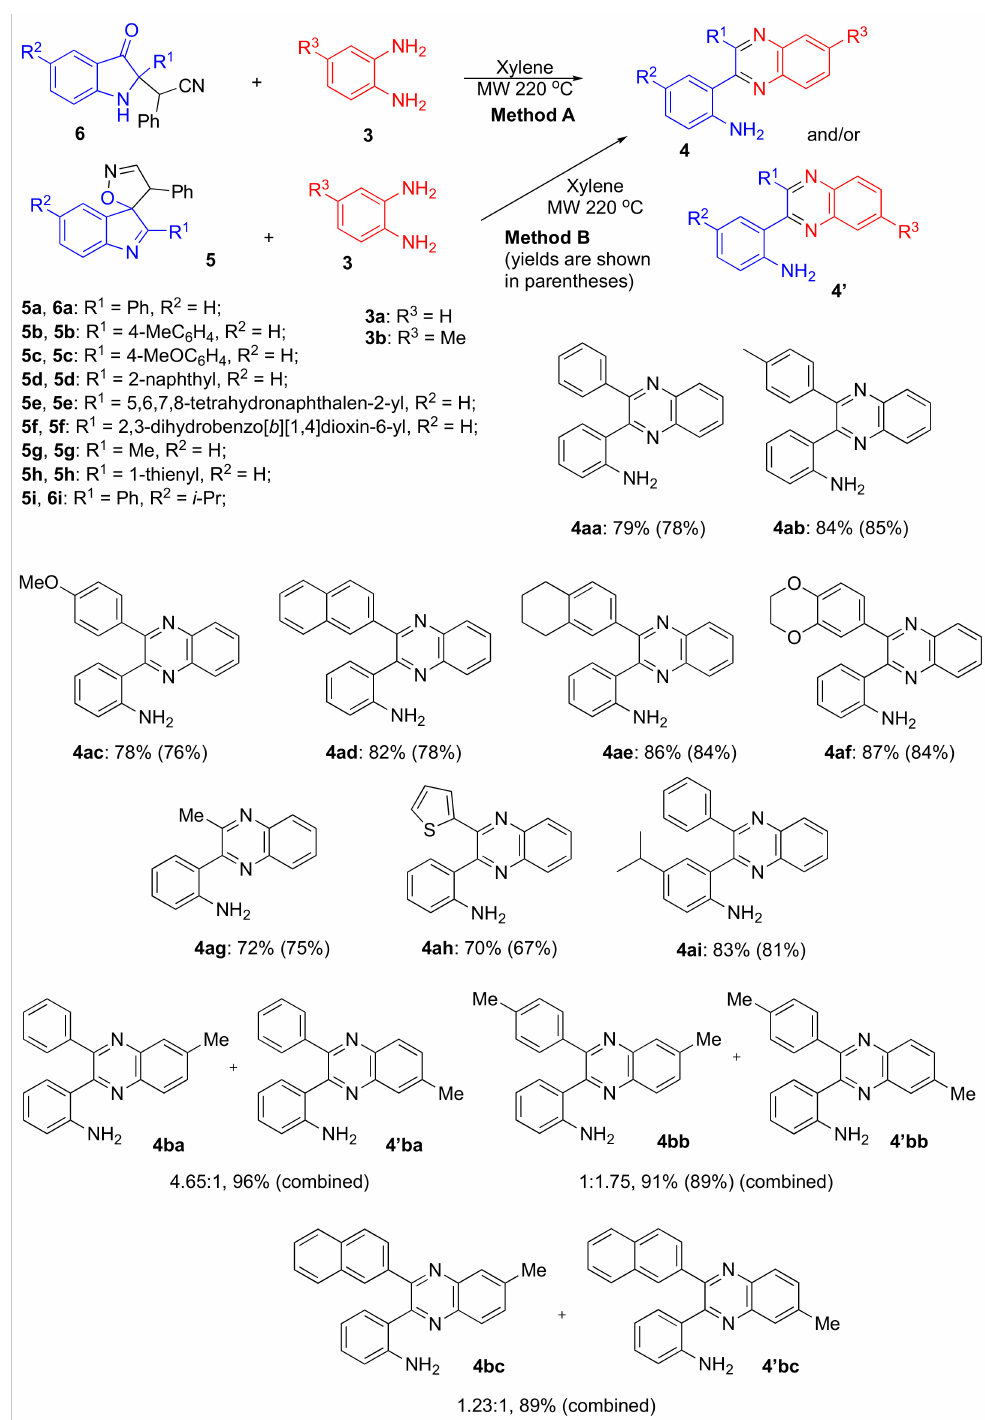
Scheme 3. Preparation of quinoxalines via Methods A and